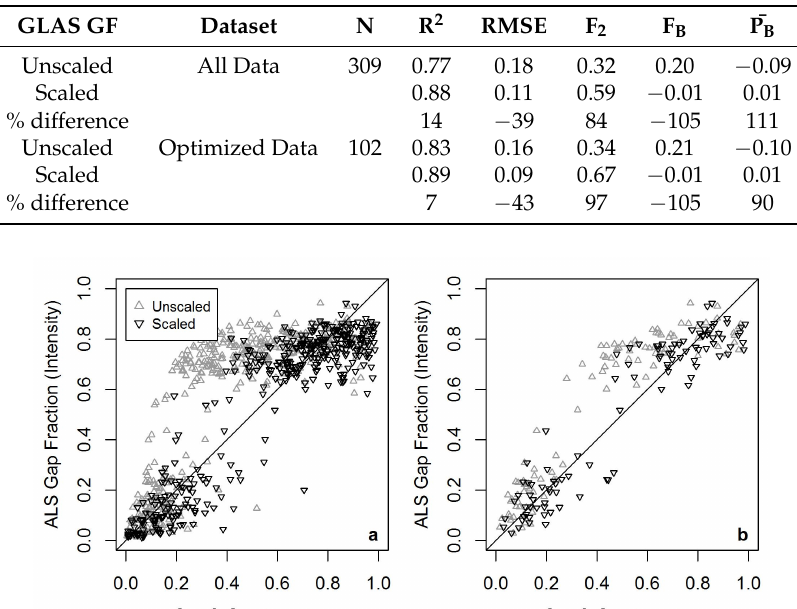
Table 3. Summary statistics (and percent change) for comparisons of ALS and GLAS estimates of GF for unscaled and scaled results per RF predicted scaling factors made across all available GLAS footprints and an optimized subset of GLAS footprints. Note: N is the population size, R 2 the coefficient of determination, RMSE the root mean squared error, F 2 the fraction of predictions within a factor of 2 of observations, F B the fractional bias and ¯P B the mean prediction bias.